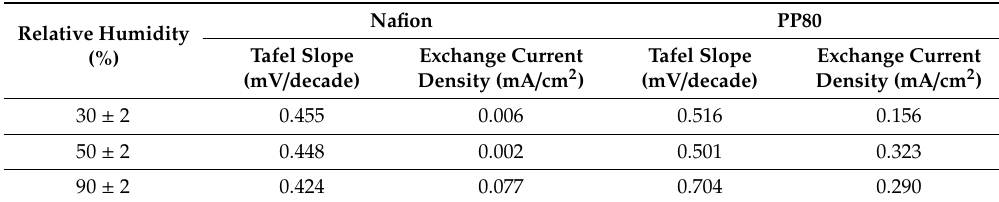
Table 1. Tafel slope and exchange current densities at di ff erent RHs and separators noted in a single chamber air cathode